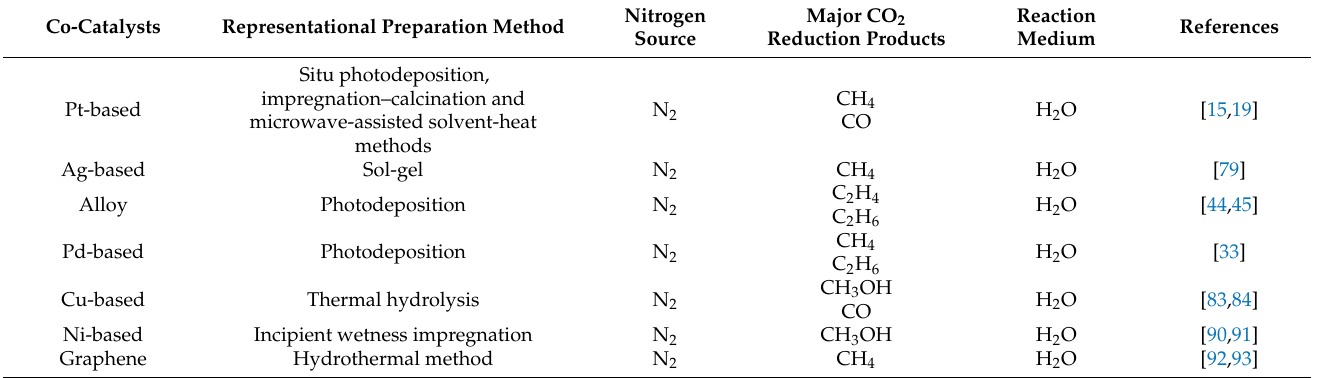
Table 2. Co-catalysts for photocatalytic CO 2 reduction of metals and non-metals.